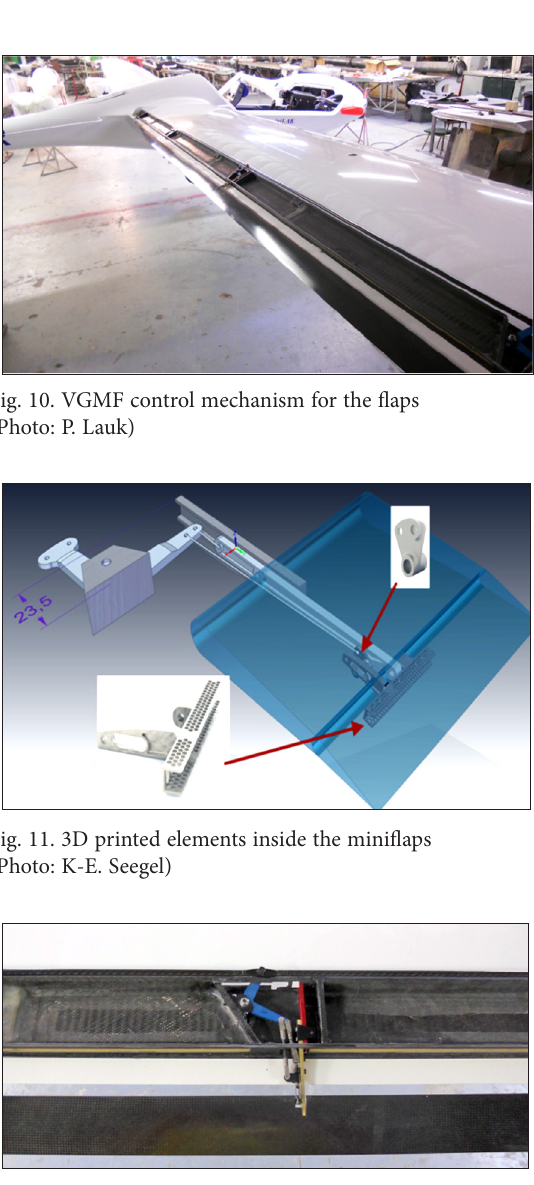
Fig. 12. The control mechanism with the miniflaps in the extended position (Photo: P.